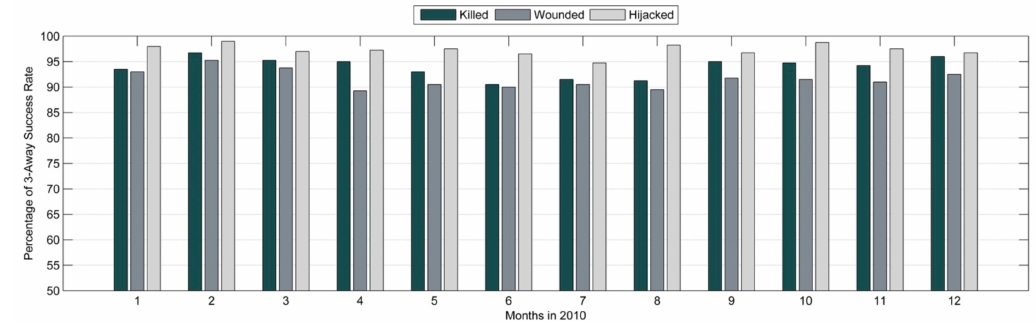
Figure 7. Percentage of three-away success rate per month in